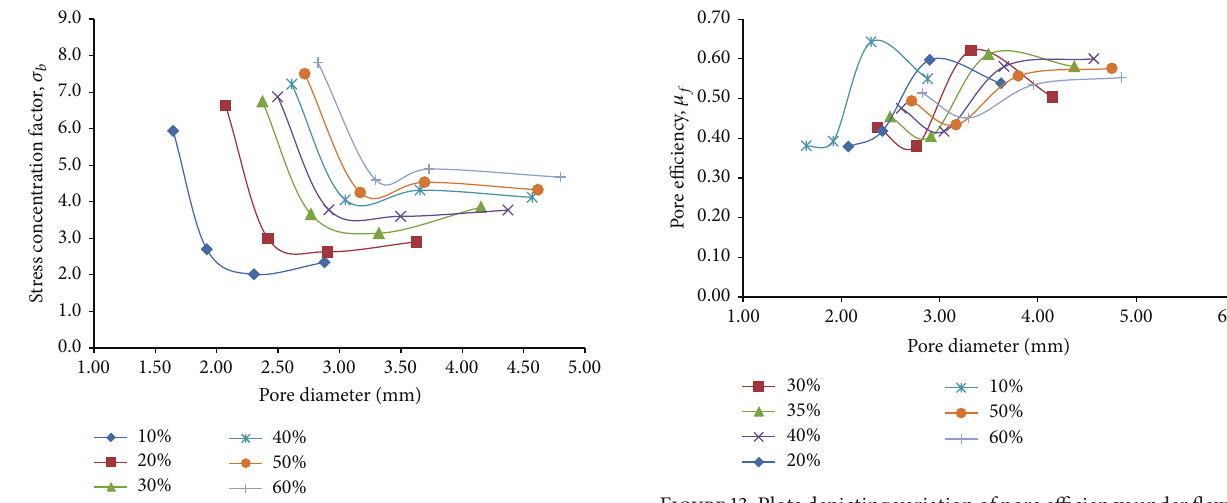
Figure 13: Plots depicting variation of pore efficiency under flexural loading, 𝜇 𝑓 , with pore diameter, for different percentages of porosity for 3D porous FE beam models subjected to flexural loading